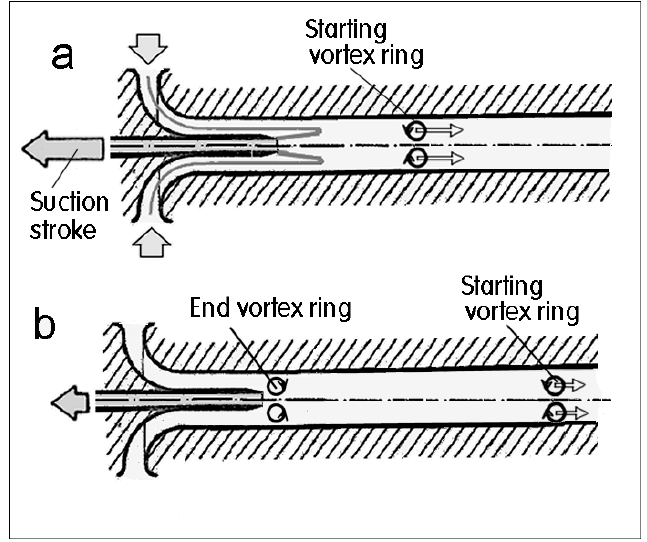
Figure 3. Schematic representation of the rectifier flows in the suction stroke period. ( a ) In the middle of the stroke, ( b ) towards the stroke end. During the cycle halves, vortex rings acting in a manner similar to those in synthetic jets are generated.